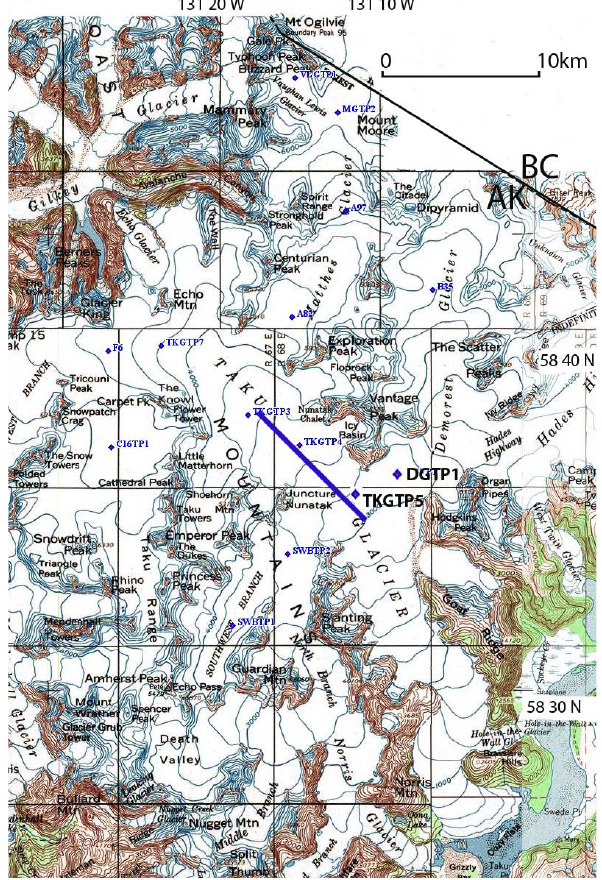
Fig. 1. Location map for Taku Glacier indicating the snowpit loca- tions and probing transect noted. The Probing transect is the solid blue line. The two key snowpits TKGTP1 and DGTP1 are indicated in bold black, other snowpits are in